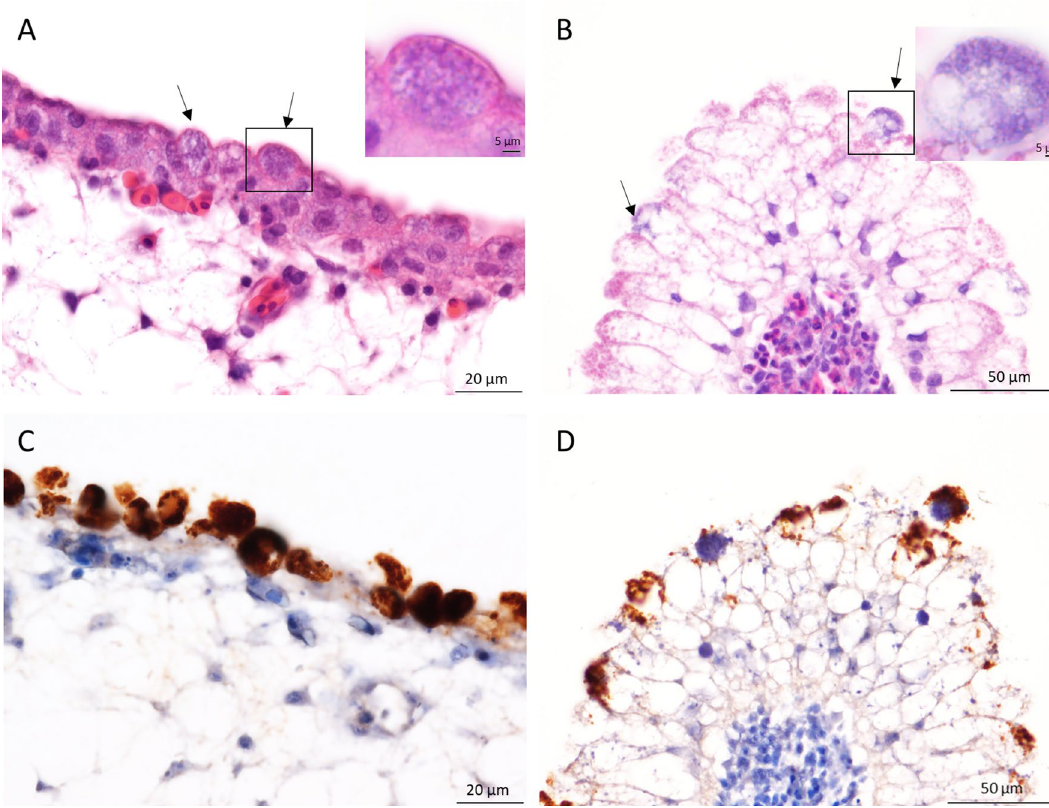
Figure 1. Chorioallantoic membrane and yolk sac membrane of 10 days embryonated eggs infected with NL_G47. Intracellular inclusions (arrows) in the epithelial cells of the chorioallantoic membrane ( A ) and yolk sac membrane ( B ). Inset: higher magnification showing the granular basophilic inclusions in the HE staining. Positive immunolabelling of the intracellular inclusions for chlamydial antigen in the chorioallantoic membrane ( C ) and yolk sac membrane ( D ). Sections were photographed with an Olympus BX51 microscope equipped with a high-resolution digital camera and using Olympus’ cellSens